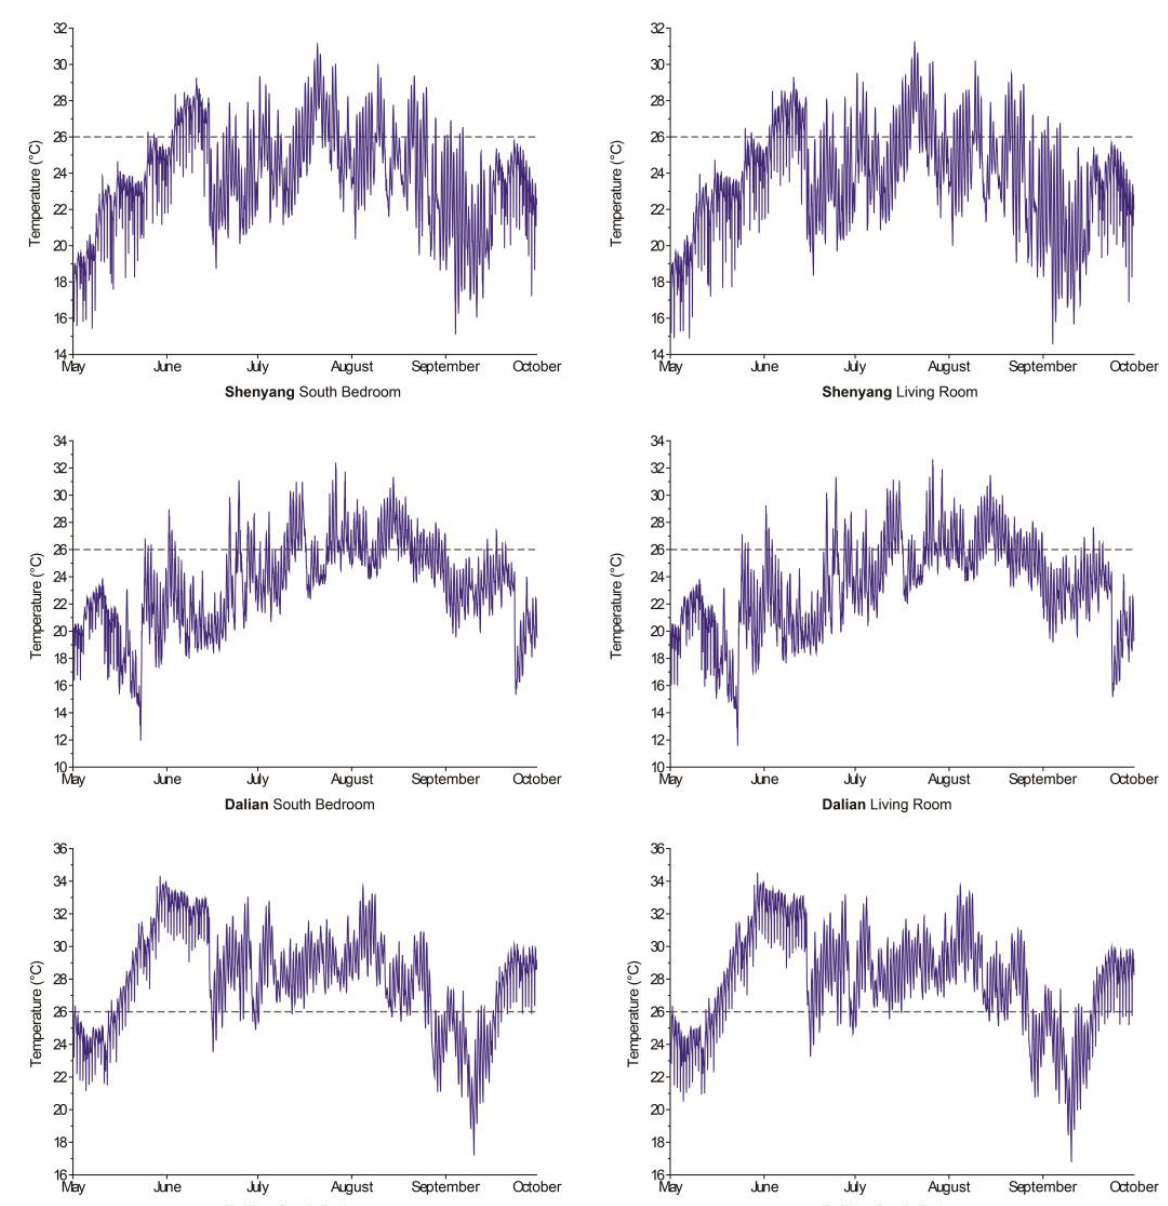
Figure 11. Indoor operative temperature in five representative cities from May to September.